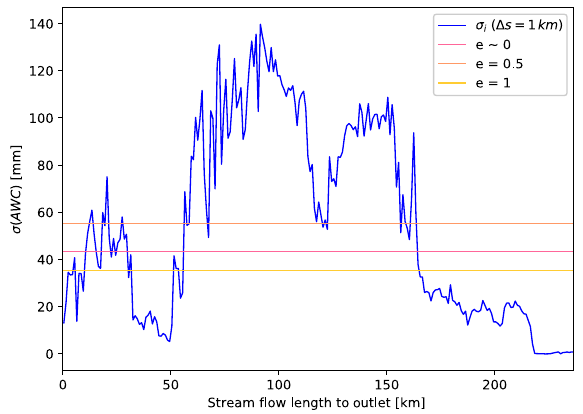
Figure 6. Distance-factor function of σ (AWC) and threshold values (cid:127) for different values of e , in the Mulde